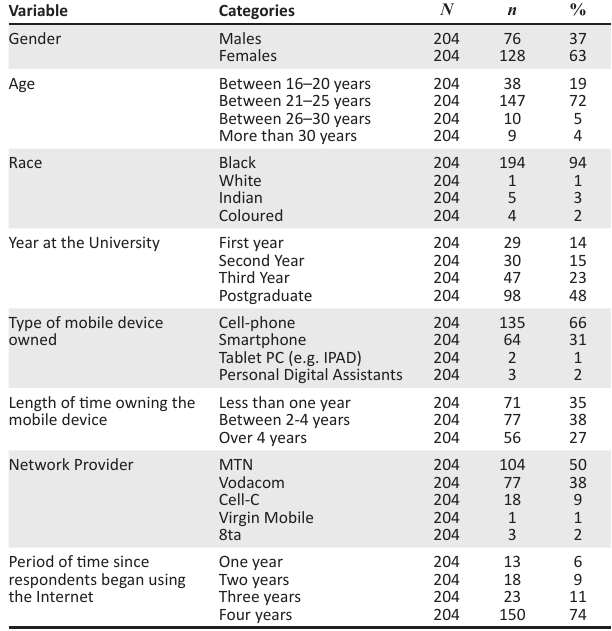
TABLE 1: Demographic composition of